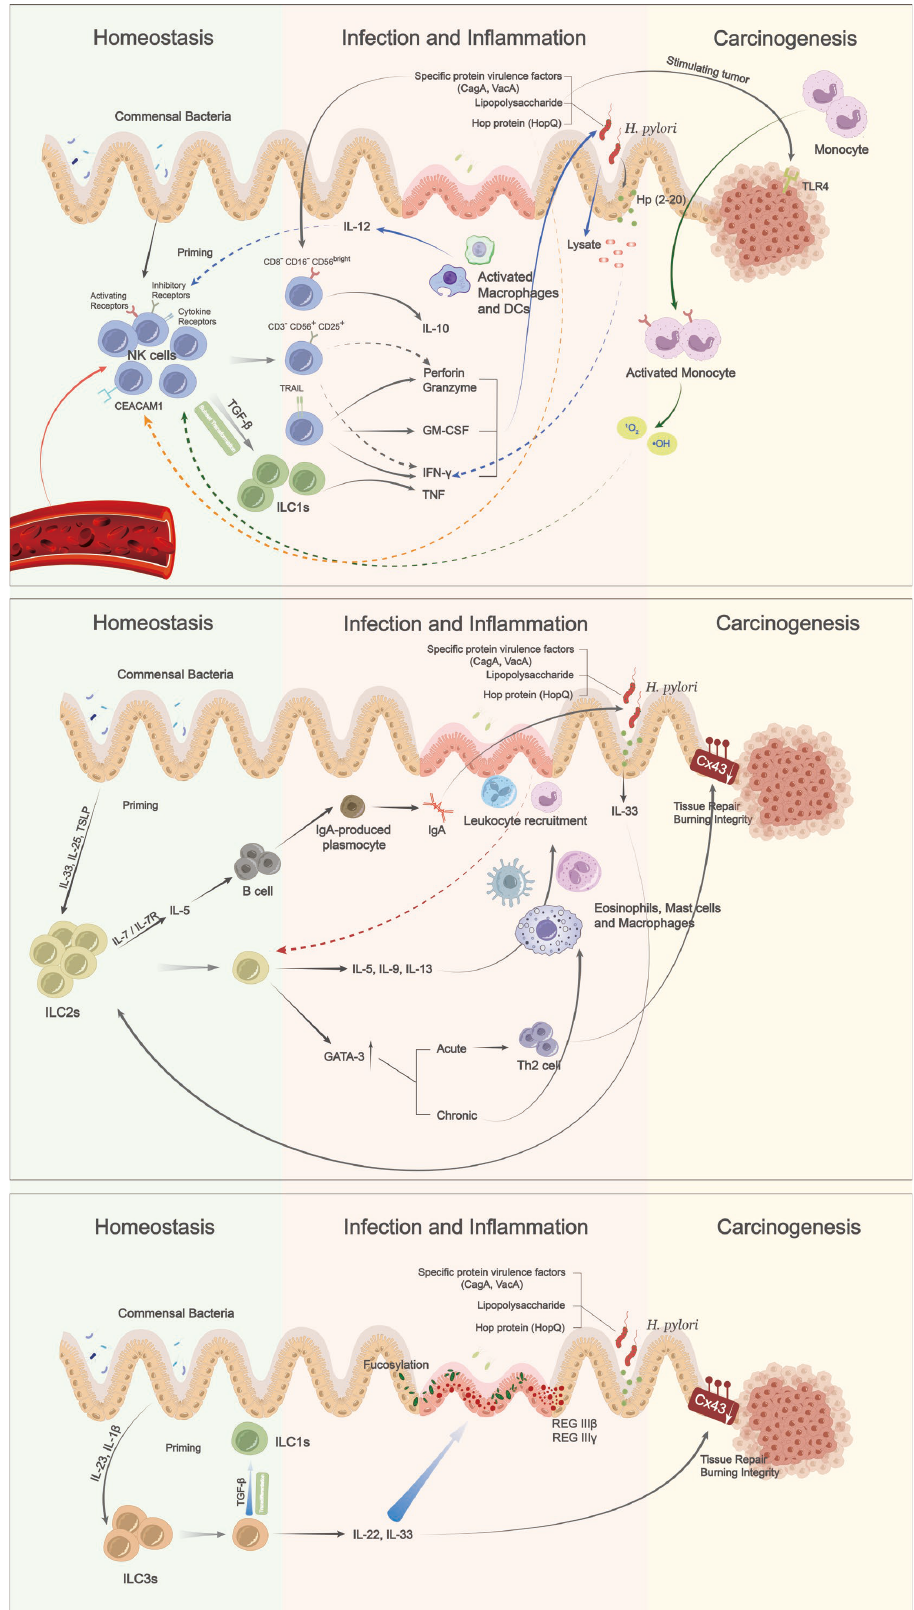
Figure 1. ILCs in regulating gastric mucosal homeostasis and their roles in gastric cancer. Group 1 ILCs consists of cytotoxic NK cells and ILC1s. NK cells rely on mucosal commensal bacteria for